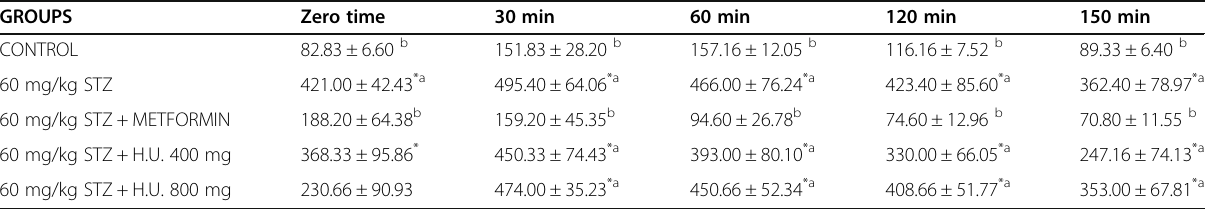
Table 2 Effect of H. umbellata on oral glucose tolerance test in diabetic rats GROUPS